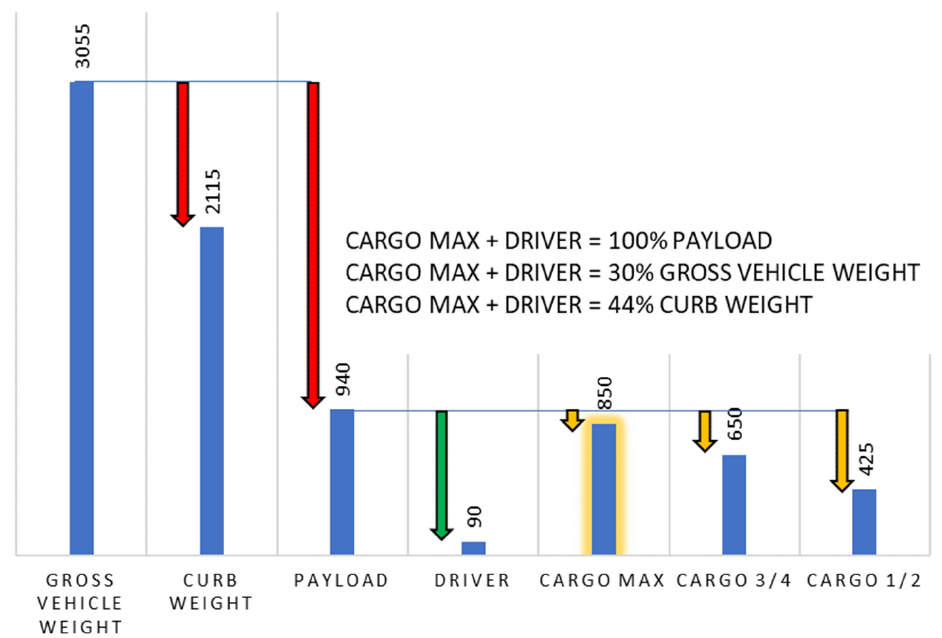
Figure 9. Weights taken into account during road surveys conducted (based on the data from the vehicle registration certificate—Figure 7).